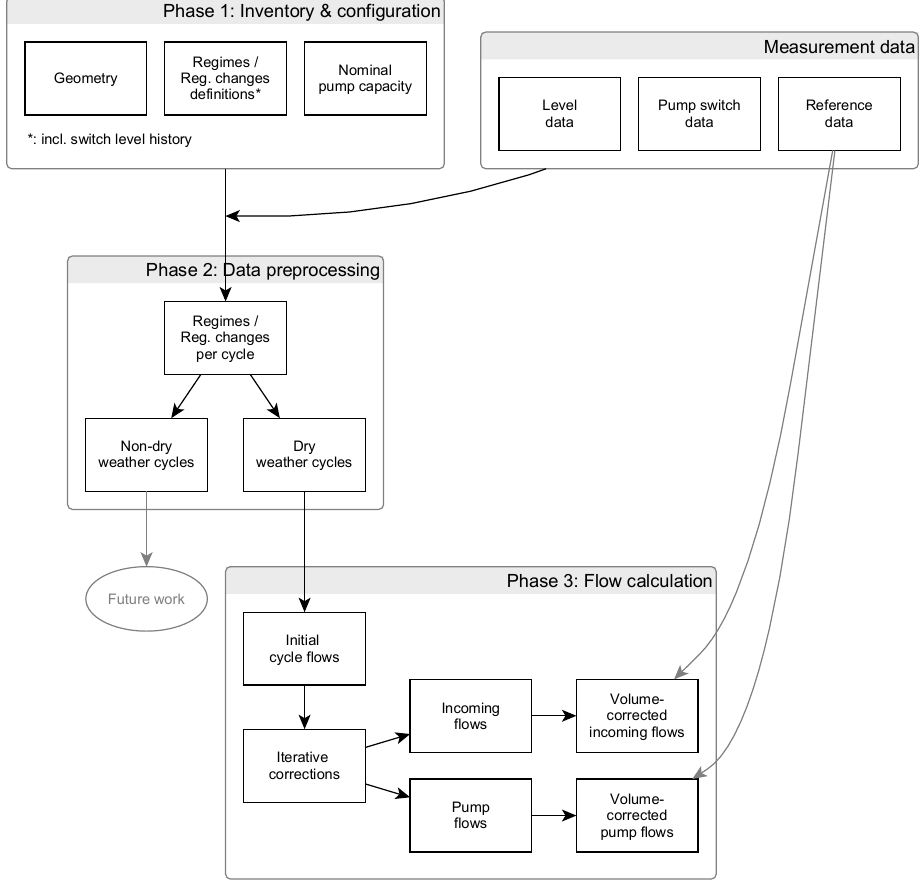
Figure 1. General flowchart of the proposed methodology.